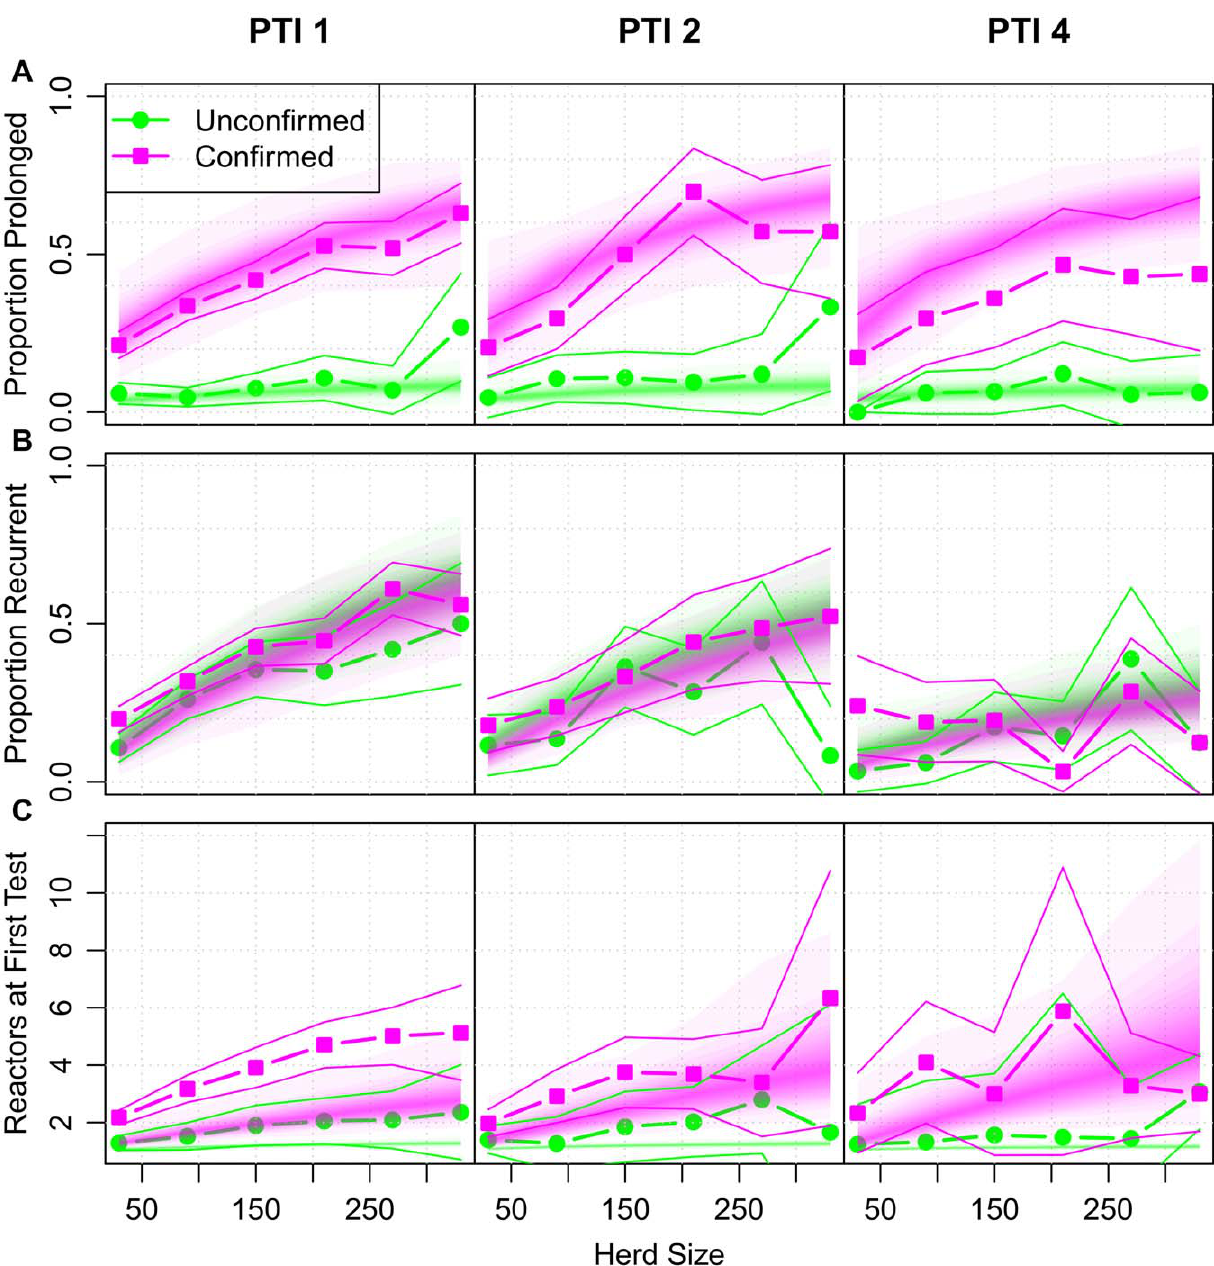
Figure 2. The persistence of bTB in GB herds (2003–2005). The within-herd persistence of bTB in GB as measured by the probability of all GB breakdowns from our study population being prolonged (duration of greater than 240 days, top panel) or recurrent within 24 months (middle panel). The relationship of each measure is plotted against herd size, with breakdowns further stratified by parish testing interval (PTI 1, 2 and 4, left to right) and confirmation status (unconfirmed breakdowns: lime green, circles, confirmed breakdowns: magenta squares). Uncertainty in each (mean) target observation (thick lines) is illustrated by an envelope (thin lines) of 6 1.96 standard errors around the mean. Predictive distributions from our within- herd (SORI) model for each of these measures are plotted as shaded density strips where the intensity of color is proportional to the probability density at that point [35].